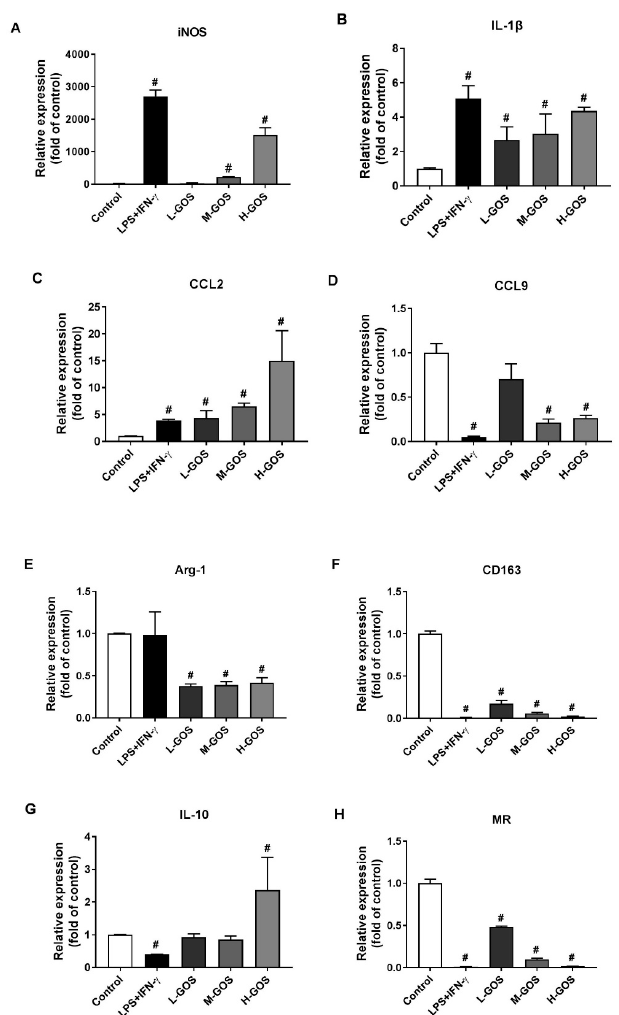
Figure 3. Effects of GOS on mRNA expression of M1 and M2 specific markers in BMDMs. The mRNA expression of M1 genes iNOS ( A ), IL-1 β ( B ), CCL2 ( C ), CCL9 ( D ), as well as M2 genes Arg-1 ( E ), CD163 ( F ), IL-10 ( G ), and MR ( H ) in BMDMs were measured by real time-quantitative polymerase chain reaction (RT-qPCR) after GOS (25 − 100 µg/mL) treatment. # —Indicated significant difference versus the control group at p < 0.05.